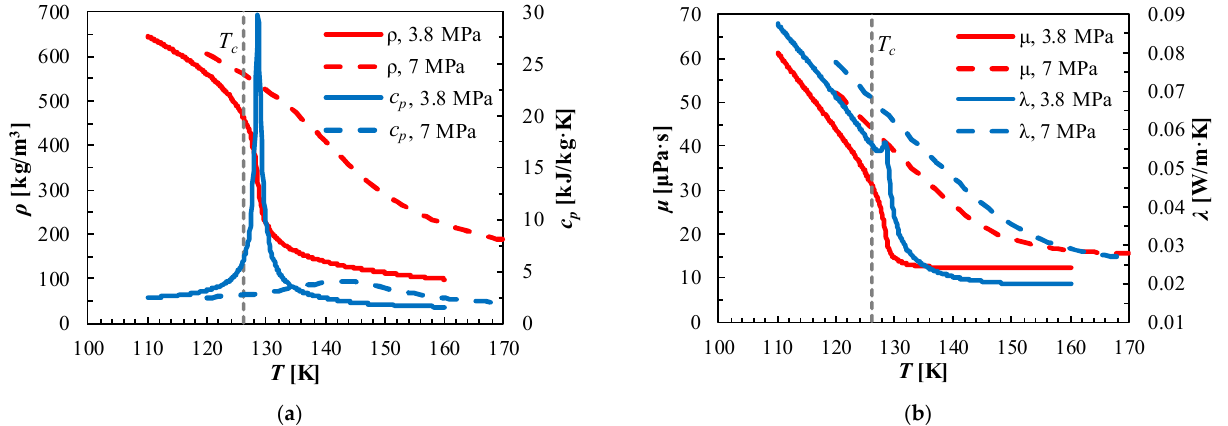
Figure 1. Variations of thermophysical properties of N 2 with temperature: ( a ) density and specific heat capacity; ( b ) vis- Figure 7. LHTCs of N 2 at p = 3.8 MPa and T in = 101 K for various values of q / G : ( a ) their variations along the test tube axis; cosity and thermal conductivity [9]. ( b ) maximum LHTCs and the corresponding locations in the